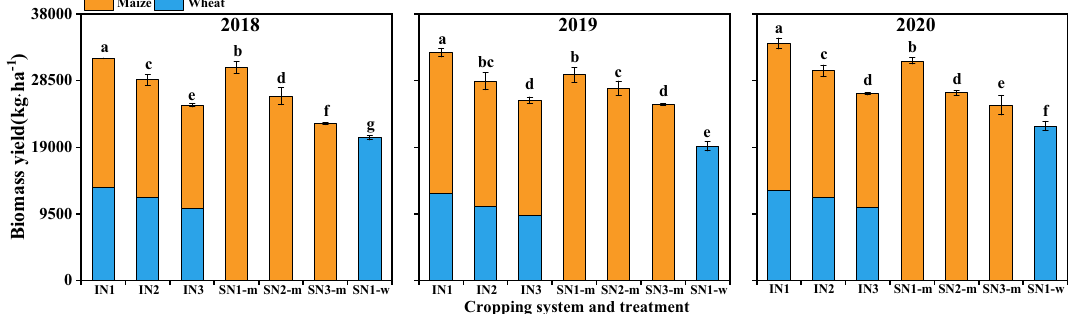
Figure 4. Biomass yield of wheat and maize with different N management practices under various cropping systems. I, intercropping, S, sole cropping. For intercropping system, N 1 , N 2 , and N 3 represent N-fertilizer applied at 51, 72, and 93 kg N ha −1 as first top-dressing plus 63, 42, and 21 kg N ha −1 at third top-dressing, respectively. For sole maize, N 1 , N 2 and N 3 represent N-fertilizer applied at 36, 72, and 108 kg N ha −1 as first top-dressing plus 108, 72, and 36 kg N ha −1 at third top-dressing, respectively. For sole wheat, N 1 represents the N-fertilizer applied at 108 kg N ha −1 as base fertilizer at sowing plus 72 kg N ha −1 top-dressed at pre-tasseling. Different lowercase above bars indicates significant difference ( P ≤ 0.05) among different N managements. Error bars indicates standard error of the means ( n = 3).